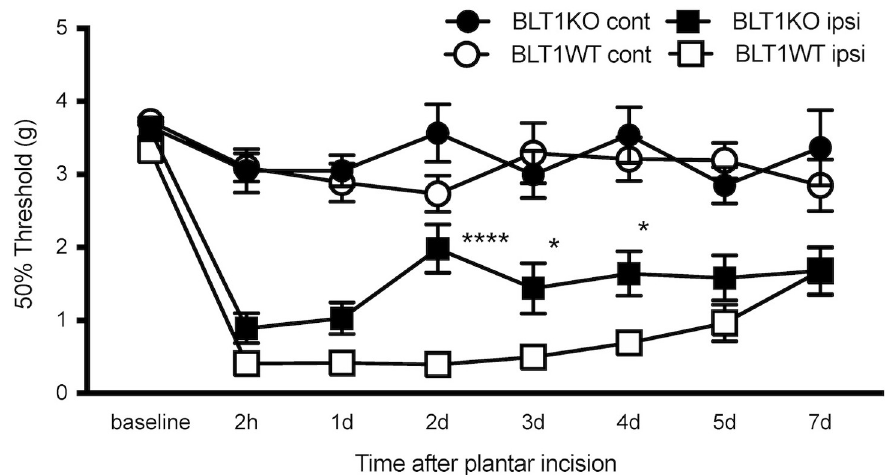
Fig 1. Effect of BLT1 blockade on mechanical withdrawal threshold after plantar incision. The 50% withdrawal thresholds in the ipsilateral and contralateral paws were measured at 2 h and 1, 2, 3, 4, 5, and 7 days after the plantar incision. The withdrawal thresholds of the ipsilateral paw decreased in both BLT1KO and BLT1WT mice. Data are shown as means ± SEM (n = 15–16 per group). A two-way ANOVA with Bonferroni post hoc tests was used for statistical analysis. � p < 0.05, ���� p < 0.0001 BLT1KO ipsilateral vs. BLT1WT ipsilateral. The withdrawal thresholds of the contralateral paw were not affected by the plantar incision.